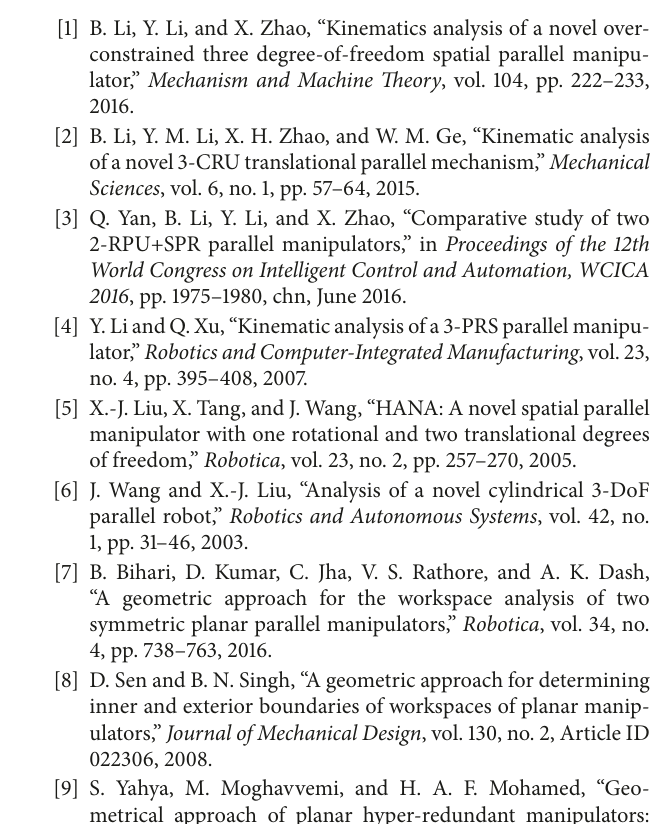
Figure 14: Finite element displacement analysis of the robot.